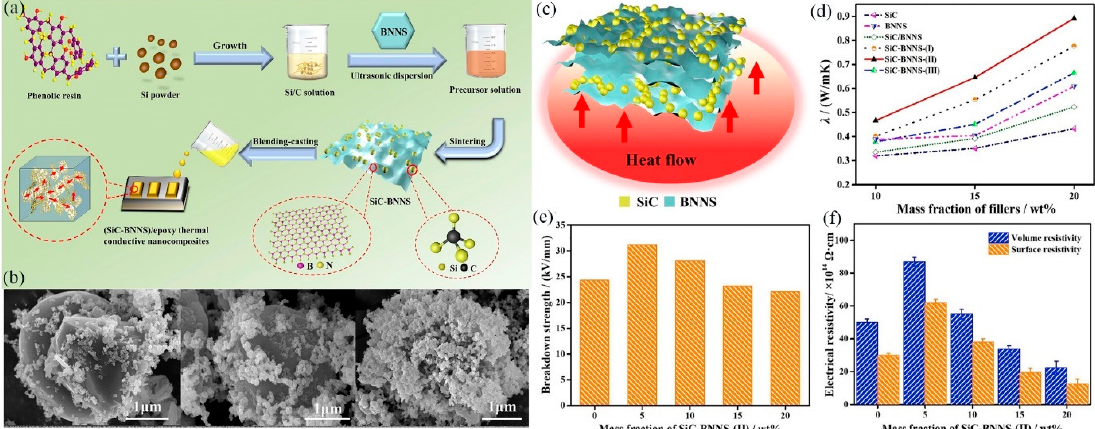
Figure 17. ( a ) Schematic diagram for the fabrication of (SiC-BNNS) / epoxy thermally conductive nano-composites. ( b ) SEM images of (SiC-BNNS, 2 / 1)-(I), (SiC-BNNS, 1 / 1)-(II), and (SiC-BNNS, 1 / 2)-(III). ( c ) Thermally conductive mechanism for hetero-structured SiC-BNNS fillers. ( d ) λ , ( e ) breakdown strength, and ( f ) electrical resistivity of the SiC-BNNS-(II) / epoxy thermally conductive nanocomposites (reproduced with permission from [153]).